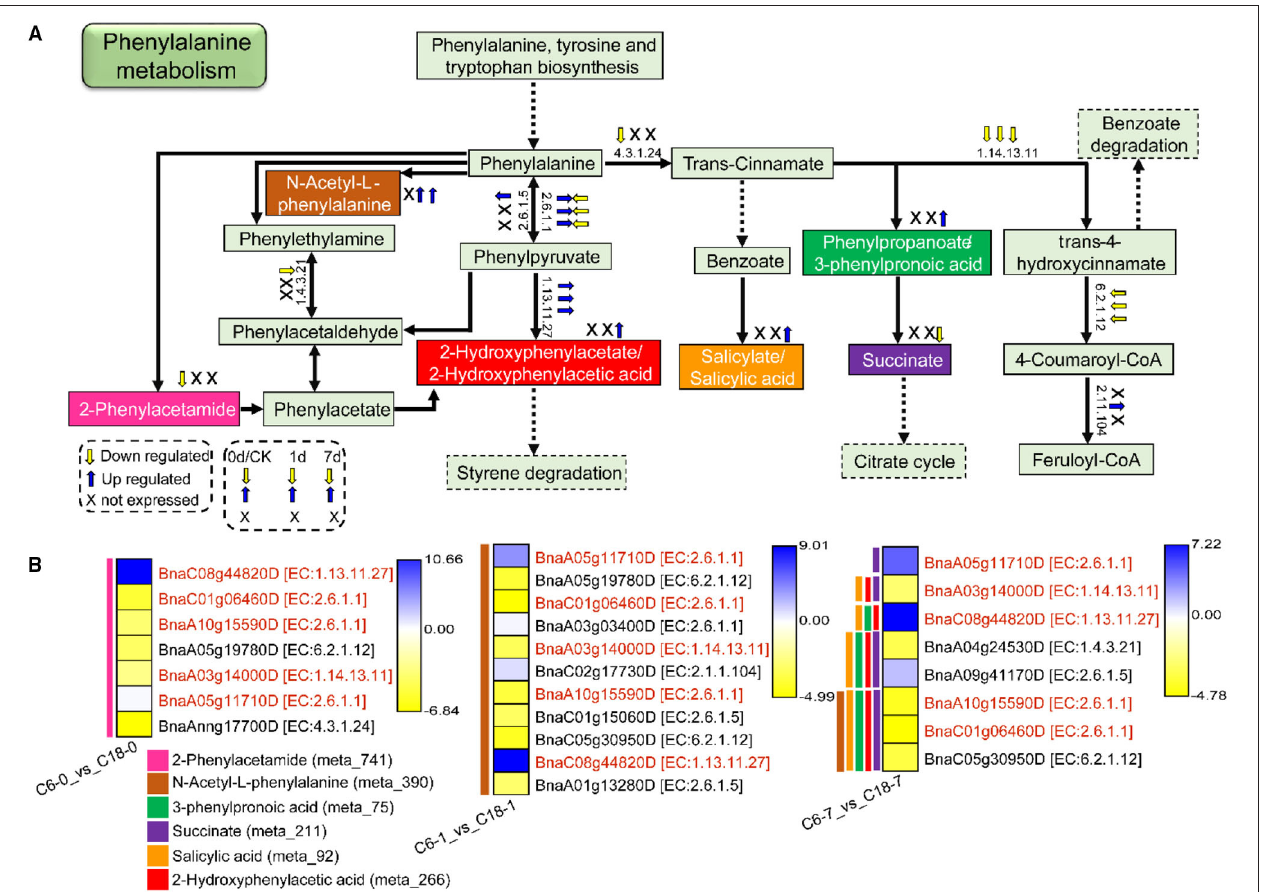
FIGURE 10 | The proposed layout of the phenylalanine metabolism pathway in response to CS in C6 and C18 cultivars. (A) Layout showing the DEGs involved in the phenylalanine metabolism. Colored boxes are indicating the metabolites observed in this pathway. This pathway shows only the DEGs that have been correlated with the metabolites from the combined analysis of transcriptomes and metabolomes. Dotted lines show the omission of some reactions. The yellow and blue arrows indicate the expression pattern (up-/downregulated) of DEGs based on the three comparisons, i.e., C6-0 vs. C18-0, C6-1 vs. C18-1, and C6-7 vs. C18-7, whereas “X” indicates not expressed at specific time points. (B) Heatmap showing the expression of DEGs corresponding to “A.” Red text color for gene names indicating the shared/common DEGs. Colored bars on the left side of each heatmap showing the metabolites correlated with DEGs based on PCC analysis. The EC numbers are